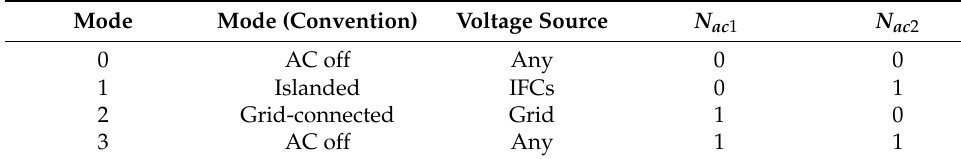
Table 6. Modes of operation at the AC